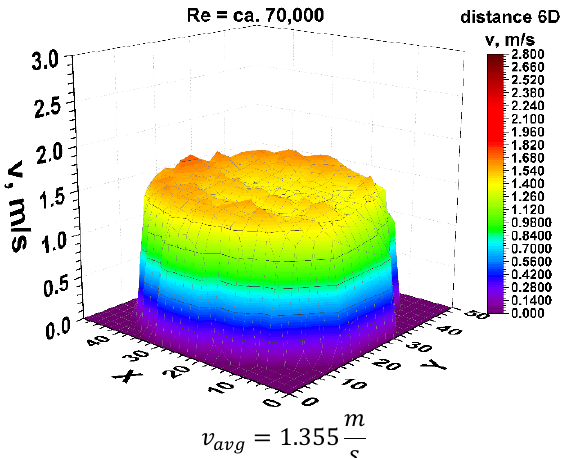
Figure 11. Velocity block at the distance 6D from the disturbance obtained by means of LDA measurements for Re ≅ 70,000.